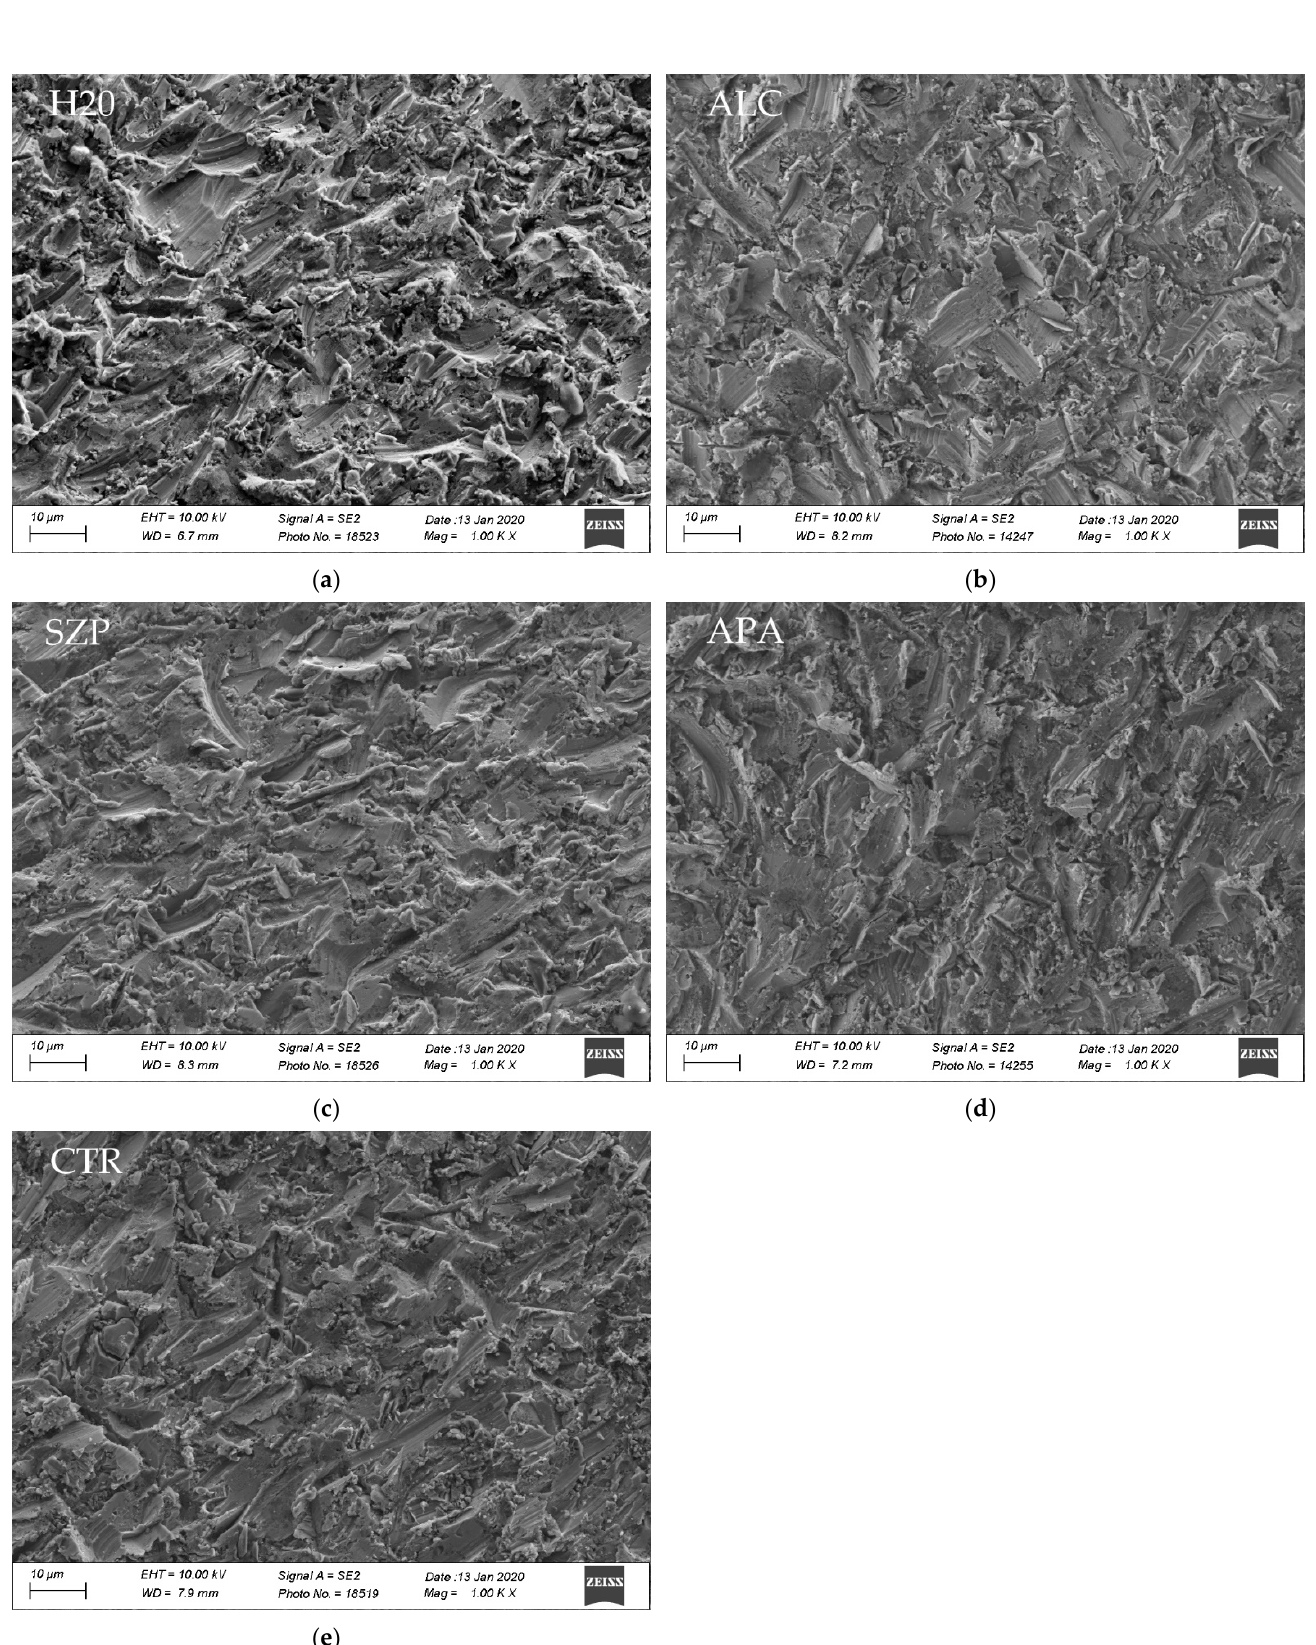
Figure 2. SEM photographs of the titanium bond surface of each group after cleaning (1000×): ( a ) water (H 2 O); ( b ) ultrasonic alcohol bath (ALC); ( c ) alkaline suspension of zirconium oxide particles (SZP); ( d ) reapplied standardized airborne-particle abrasion (APA); ( e ) control without contamination (CTR).